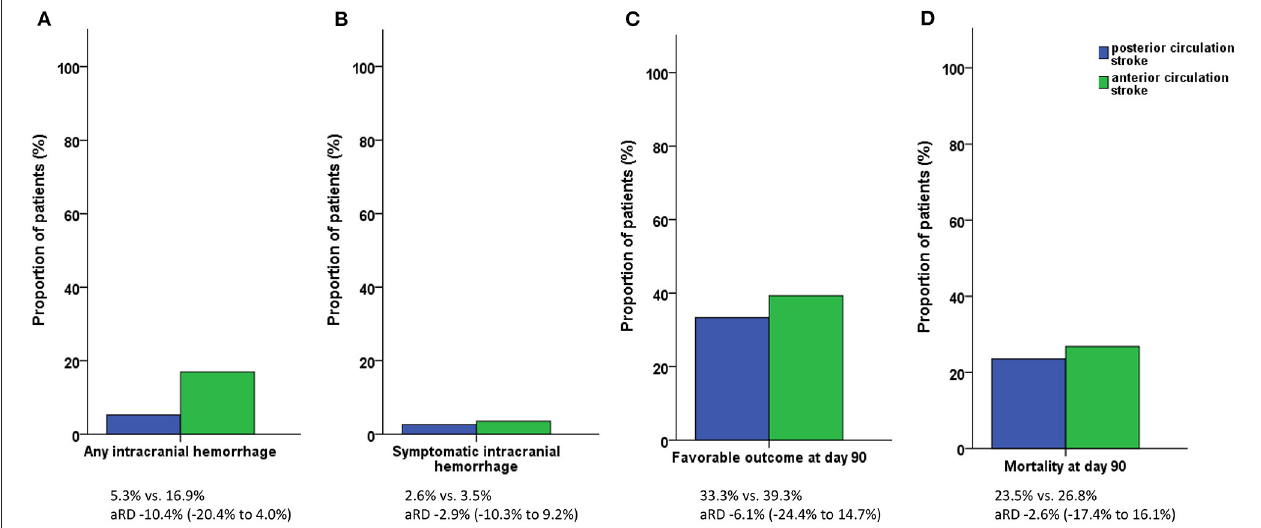
FIGURE 3 | Study outcomes. (A) Incidence of any intracranial hemorrhage. (B) Incidence of symptomatic intracranial hemorrhage. (C) Functional outcome at day 90. (D) Mortality at day 90. Symptomatic intracranial hemorrhage according to the ECASS III criteria. Favorable outcome defined as pre-modified Rankin Scale (mRS) or mRS score 0–2.